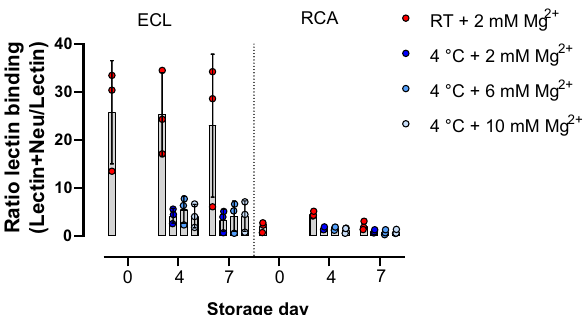
Figure 4. Impact of Mg 2+ addition to desialylation of platelets. Binding of fluorescently labeled Erythrina cristagalli lectin (ECL) and Ricinus communis agglutinin (RCA) to platelet surface glycoproteins of RT and cold- stored platelets with or without Mg 2+ in the presence and absence of sialidase during 7 days storage. RT room temperature, Mg 2 + magnesium. n = 3, mean + standard